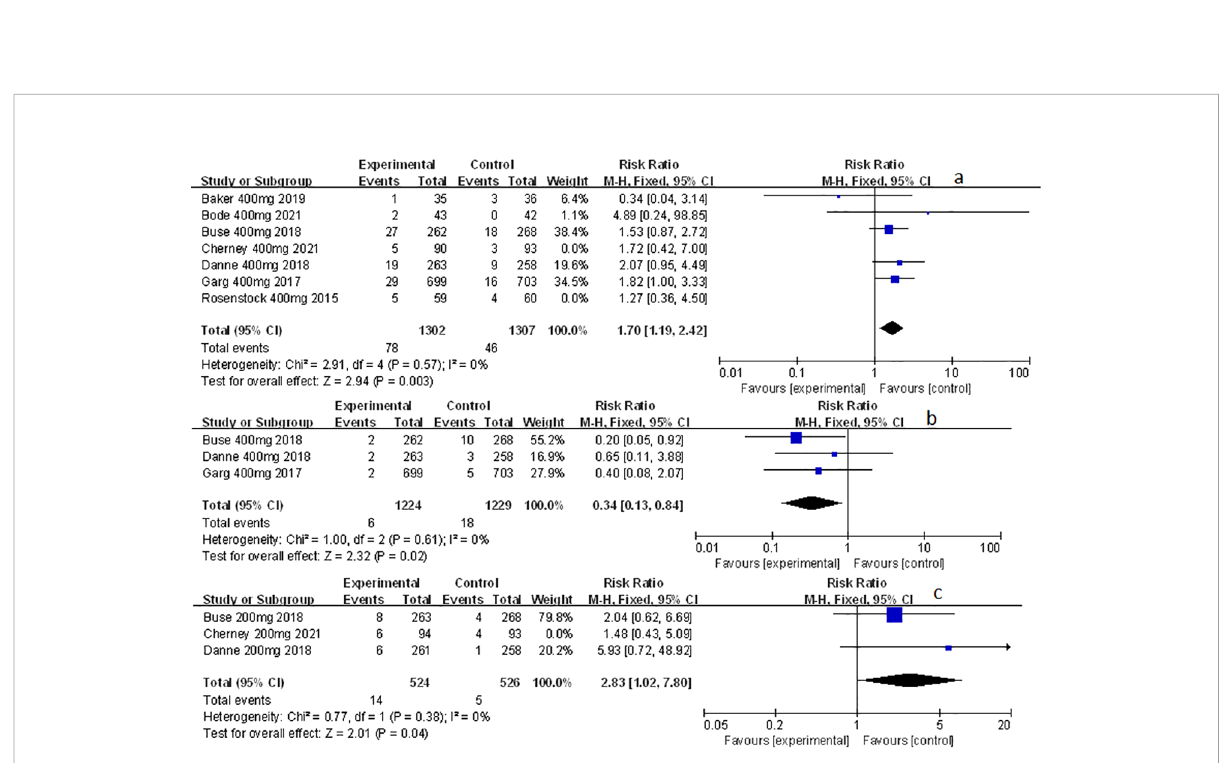
FIGURE 7 Forest plot of the other related adverse events in the subgroup of sotagli fl ozin 400mg and 200mg versus the control group in T1D. (A) The adverse event of diarrhea in sotagli fl ozin 400 mg versus placebo. (B) The adverse event of severe nocturnal hypoglycemia event in sotagli fl ozin 400 mg versus placebo. (C) The adverse event of volume depletion in sotagli fl ozin 200 mg versus